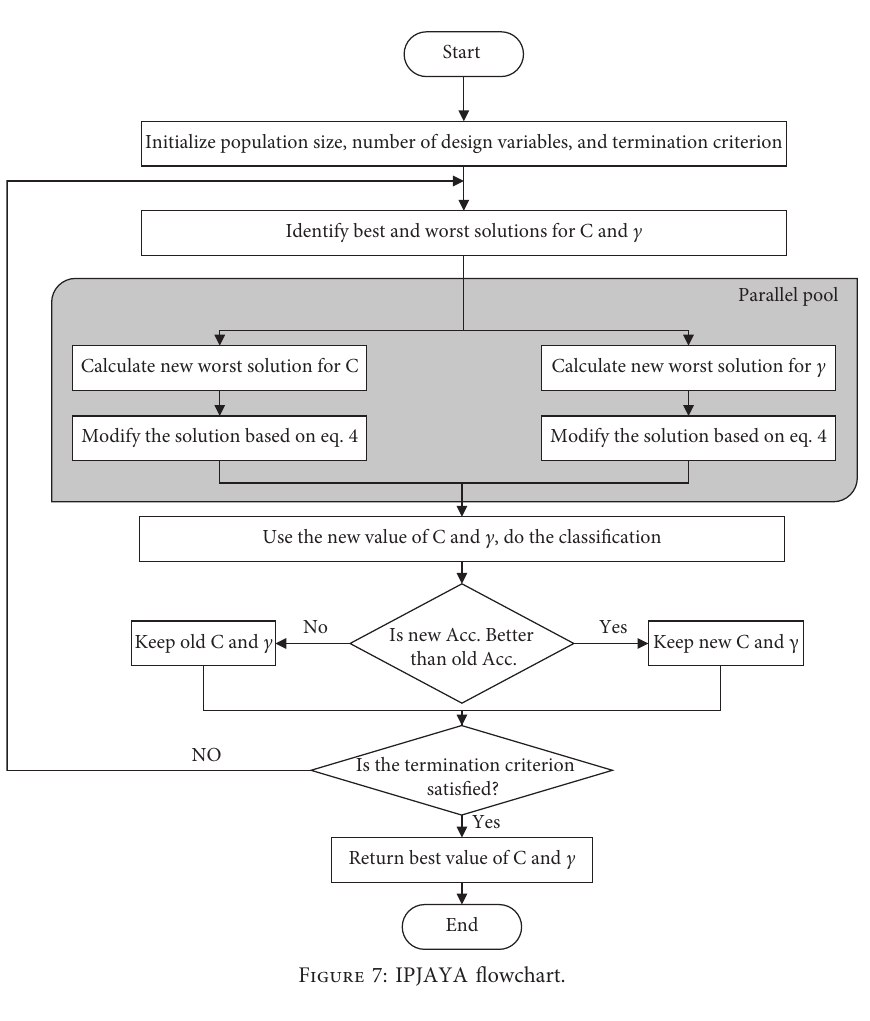
Table 3: Evaluation of C.